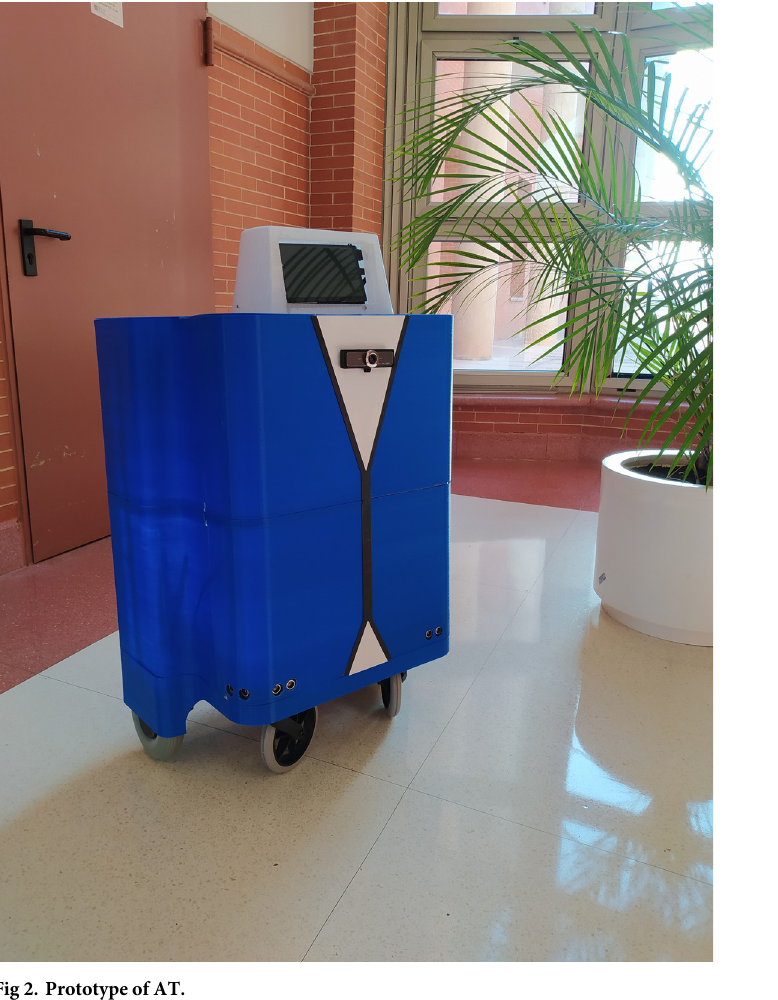
Fig 2. Prototype of